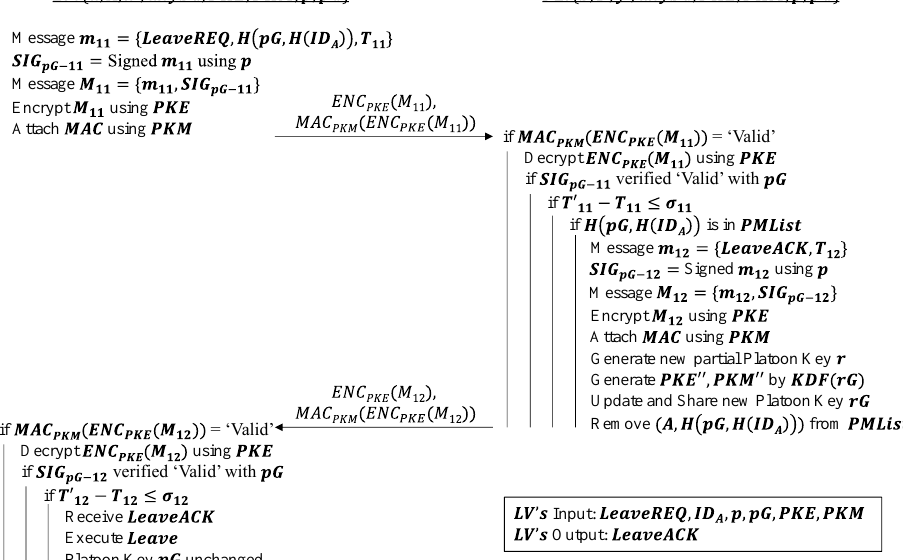
Figure 6. Exit Request Phase of the SPMSA Scheme.